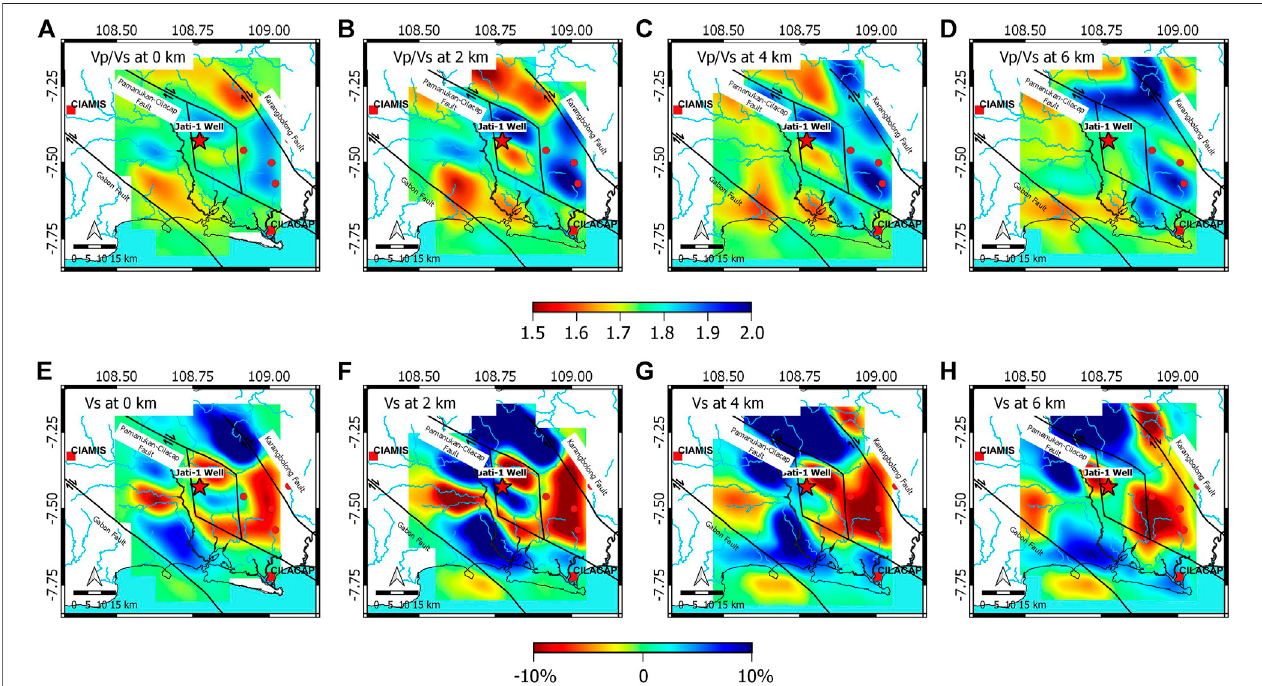
FIGURE 8 | Horizontal sections Vp/Vs ratio and the Vs structure at (A) 0 km depth, (B) 2 km depth, (C) 4 km depth, and (D) 6 km depth, and perturbation of Vs anomaly at (E) 0 km depth, (F) 2 km depth, (G) 4 km depth, and (H) 6 km depth. Based on an anomaly contrast of Vp/Vs ratio at 2 and 4 km depth, we assume that Pamanukan – Cilacap strike-slip fault formed an echelon structure that controls the depocenter of the Banyumas Basin.